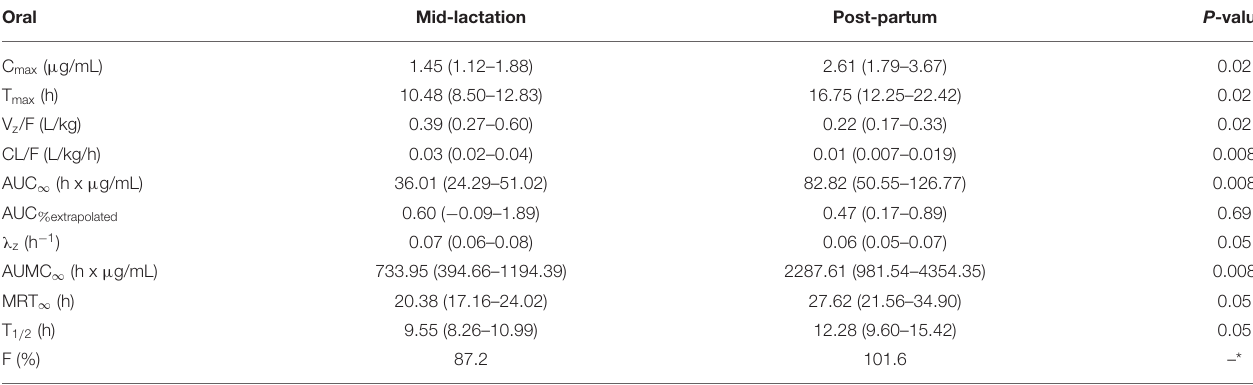
TABLE 5 | Plasma pharmacokinetic parameters for meloxicam from six post-partum cows matched to mid-lactation cows orally administered a single dose of meloxicam at 1.0